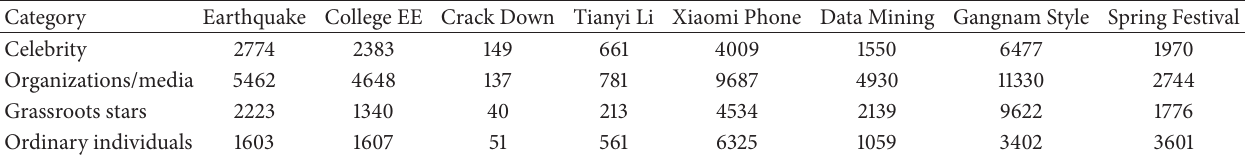
Table 13: The number of URLs adopted by different categories of